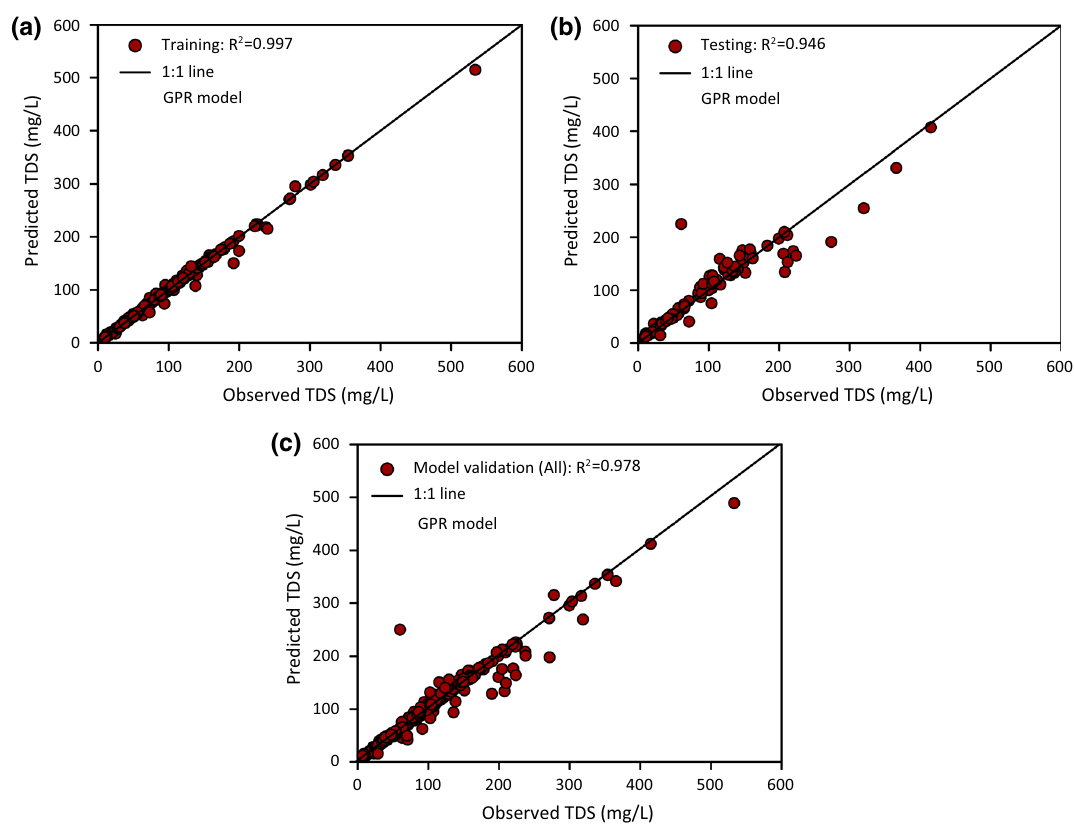
Fig. 3 Prediction accuracy of GPR model for: a training; b testing; and c